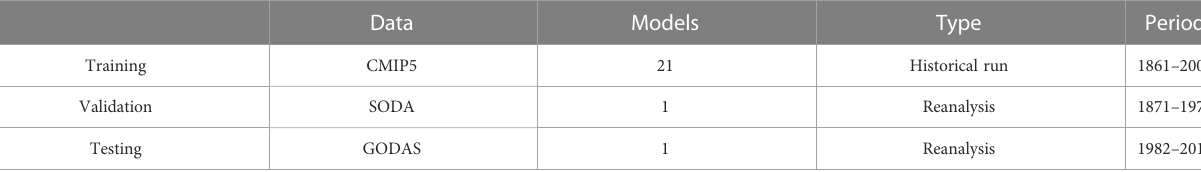
TABLE 2 The training, validation and testing subsets for Niño3.4 index prediction on CMIP5 dataset.